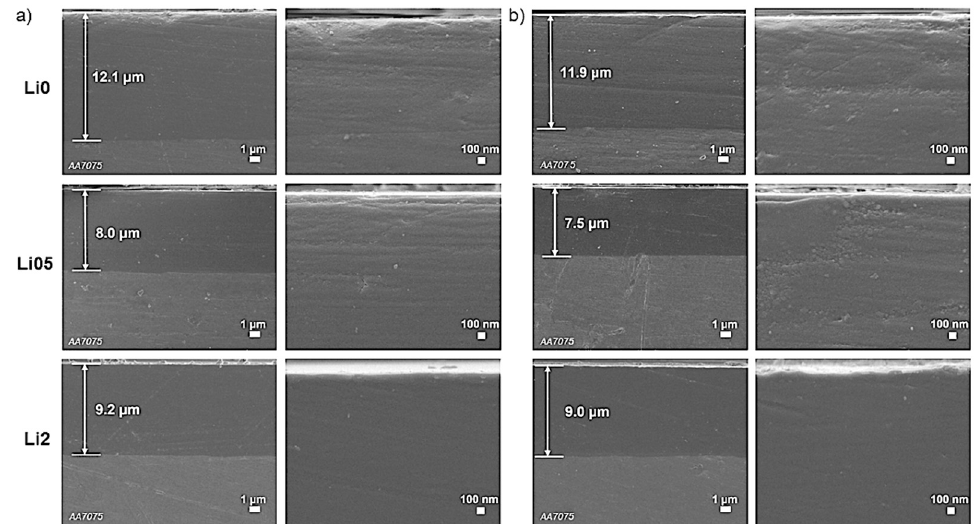
Figure 8. SEM cross-sectional images of Li0, Li05, and Li2 coatings ( a ) before and ( b ) after long-term exposure in 3.5% NaCl solution (the horizontal scratches are polishing marks).